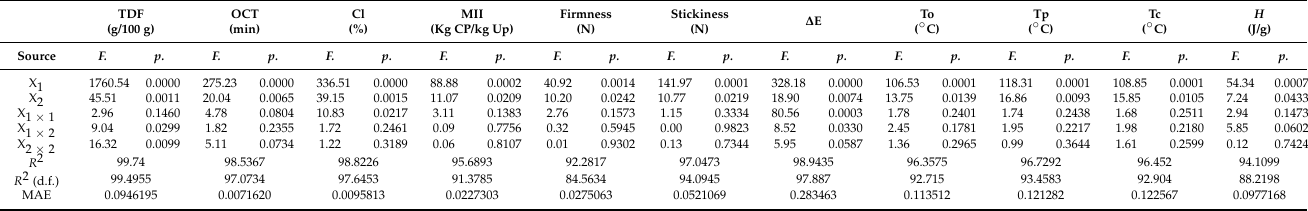
Table 6. Data analysis of the effect of alcohol insoluble residue from potato peel byproduct (AIR-PPB) and particle size (PS) on chemical and physical properties of fiber-enriched pasta